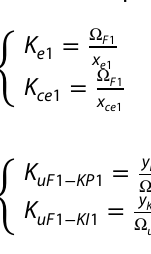
/ K for fuzzy logic controller P 1 I 1